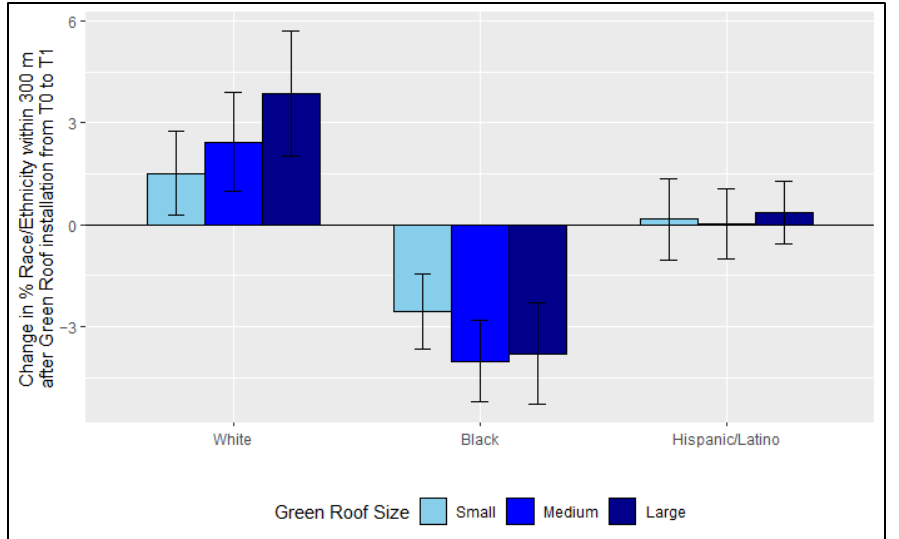
Figure 5. Change in percent of residents who are White, Black, and Hispanic/Latino surrounding green roof installation of varying sizes. Error bars represent 95% confidence intervals. SCMs were installed in some, but not all Census block groups between the year T0, the first 5-year interval, and T1, the last 5-year interval.